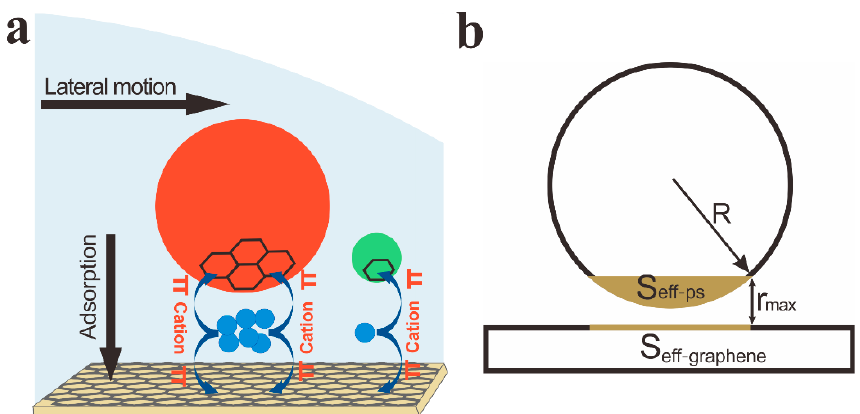
Figure 4. ( a ) Schematic diagram of cation-controlled separation. Cations mediate the adsorption between particles of different sizes and the aromatic substrate via hydrated cation- π interactions in a sessile droplet. The red/green and blue spheres denote the large/small colloidal particles and the cations, respectively. ( b ) Schematic diagram of the effect interaction areas of the hydrated cation- π interactions on the particle surface S eff-ps and graphene substrate S eff-graphene .